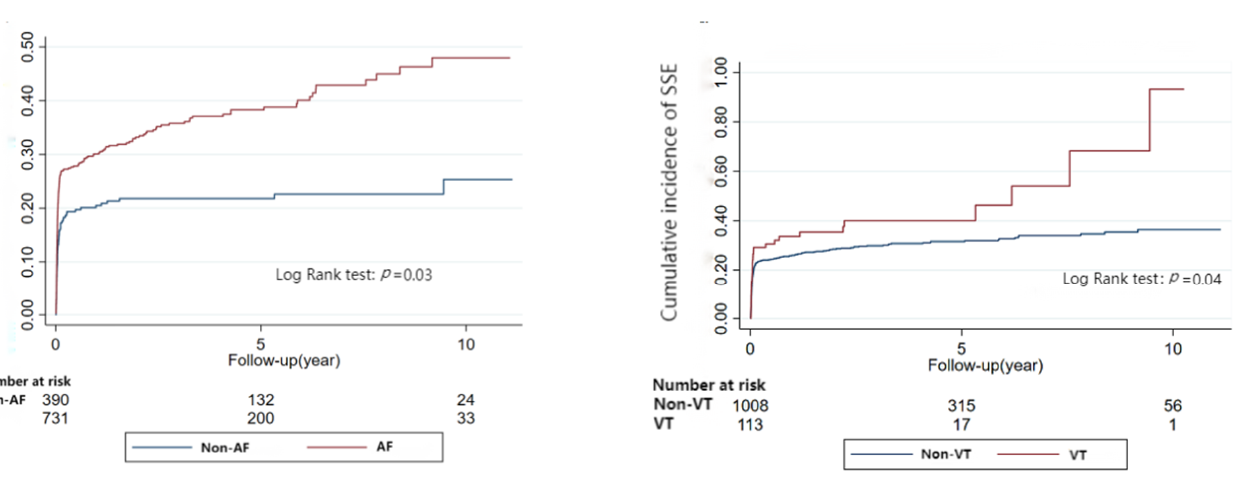
Figure 1. Relationship between arrhythmia and stroke and systematic embolism in restrictive cardiomyopathy (Kaplan-Meier Analyses).